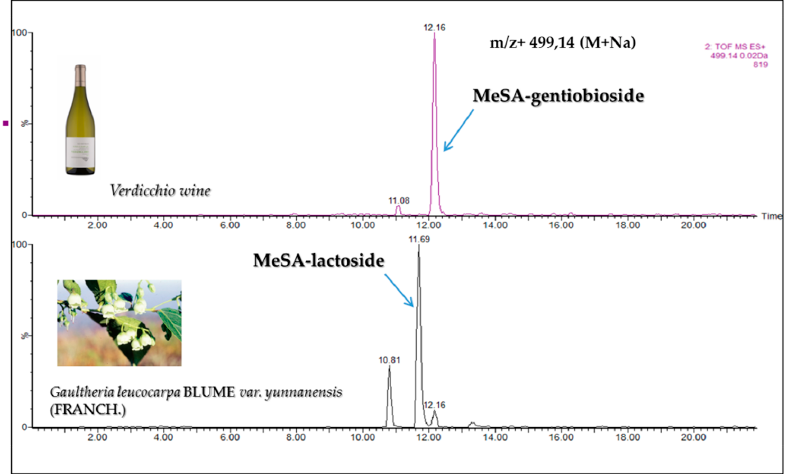
Figure 3. Extracted chromatogram of m / z 499.14 with the 2 diglycoside isomers. MeSA-gentiobioside is the only one present in Verdicchio wine .